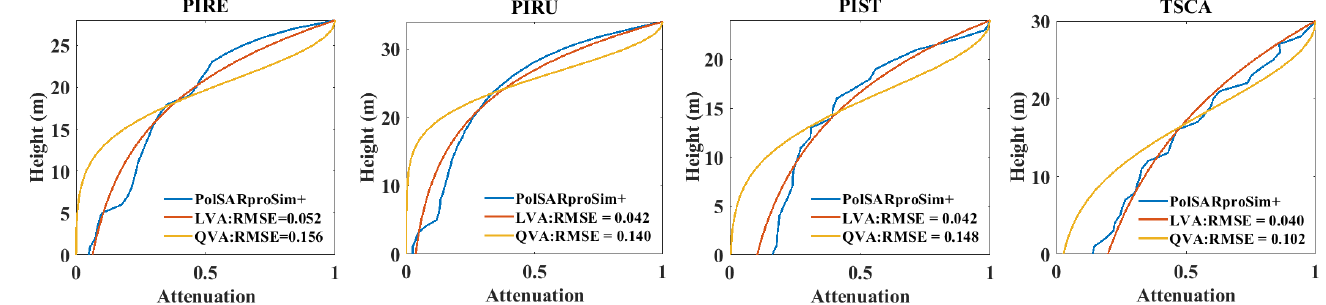
Figure 8. Vertical scattering attenuation fitting results of the coniferous forest stands (see Table 1 for an explanation of the acronyms).